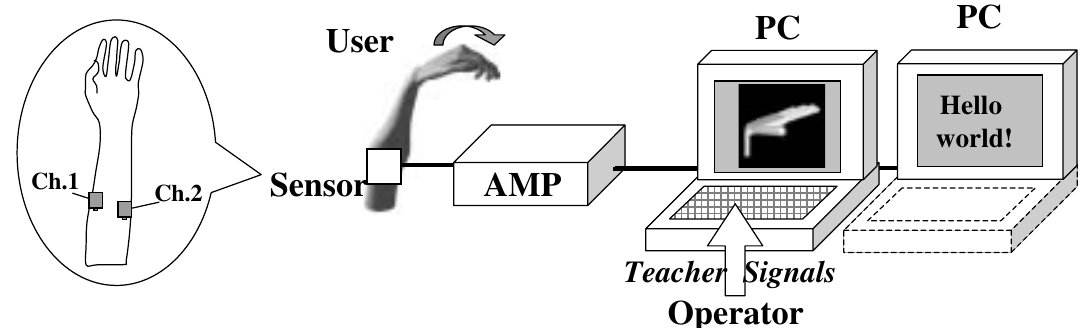
Figure 4 Experiment setting. The subject gestures are illustrated in Figure 5 by icons of CG (computer graphics) hand used in the experiment.